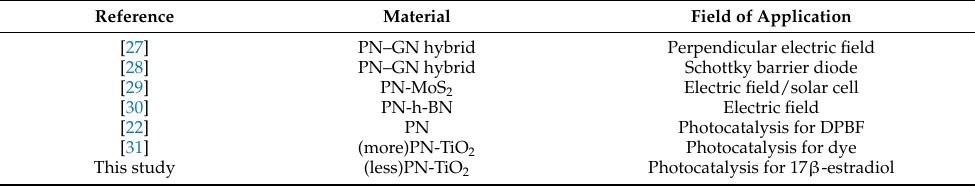
Table 2. PN and PN-based hybrids and their fields of